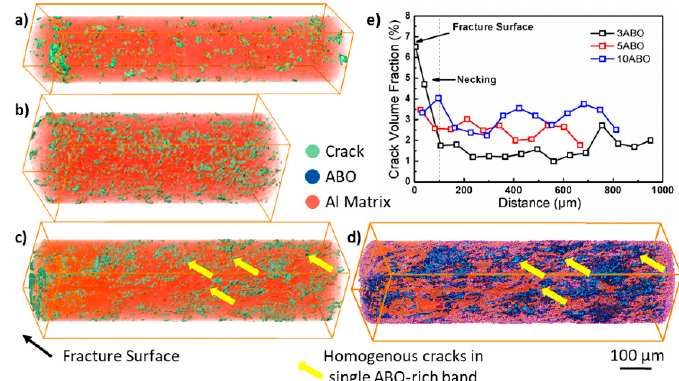
Figure 9. ( a – c ) 3D renderings of the crack distributions in the fractured specimens of aluminum metal composites with 3 vol. %, 5 vol. %and 10 vol. % aluminum borate content, respectively. ( d ) The aluminum borate (ABO) distribution in the fractured aluminum metal composites with 10 vol.% aluminum borate content. The ABO-rich bands facilitate the nucleation of small cracks as marked by arrows. ( e ) The quantitative relationship of the crack volume fraction versus the distance away from the fracture surface [46].